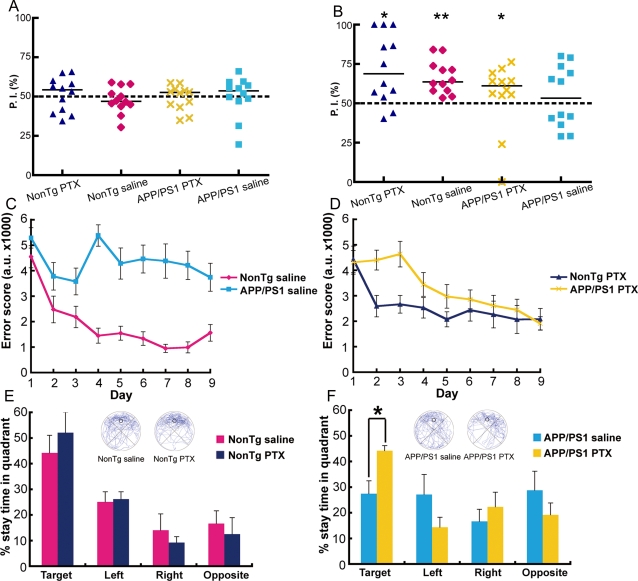
Memory facilitation in adult APP/PS1 mice treated with PTX.The effect of 10-day PTX treatment (at a non-epileptic dose) on short-term object recognition memory was tested with a NOR task. Long-term spatial reference memory was tested with the MWM task. (A, B) Preference indices (P. I.) during training (A) and testing (B) in the NOR task in PTX- and saline-treated nonTg and APP/PS1 mice (n = 6 per group). Adult APP/PS1 mice showed partial recovery of object recognition memory with PTX treatment; *p = 0.0161 and **p = 0.000244, binomial analysis for accessing novel objects. (C, D) Learning session error scores of saline-treated nonTg and APP/PS1 mice (C) and PTX-treated nonTg and APP/PS1 mice (D) tested on the MWM task. In saline-treated groups, adult APP/PS1 mice showed spatial learning impairment (F[1,10] = 13.73, p = 0.0041; repeated measures two-way ANOVA). In PTX-treated groups, there was no significant difference between APP/PS1 and nonTg mice (F[1,10] = 3.08, p = 0.1099; repeated measures two-way ANOVA). (E, F) Performance during the probe trial showed significant improvement in PTX-treated APP/PS1 mice (preference in target quadrant over other quadrants; p = 0.0057; the Friedman test). The swimming traces of the mice are shown in blue. The target quadrant is indicated by a circle, which represents the location of the platform during training; *p = 0.0260; two-tailed Mann Whitney U test. The ages of mice were 9–13 months (10.9±1.6 months) for nonTg saline; 9–10 months (9.9±0.1 months) for nonTg PTX; 9–13 months (11.1±1.7 months) for APP/PS1 saline; and 9–13 months (10.8±1.7 months) for APP/PS1 PTX mice. The nonTg mice used in the drug-treatment experiments were wild-type littermates and controls of the APP/PS1 line.